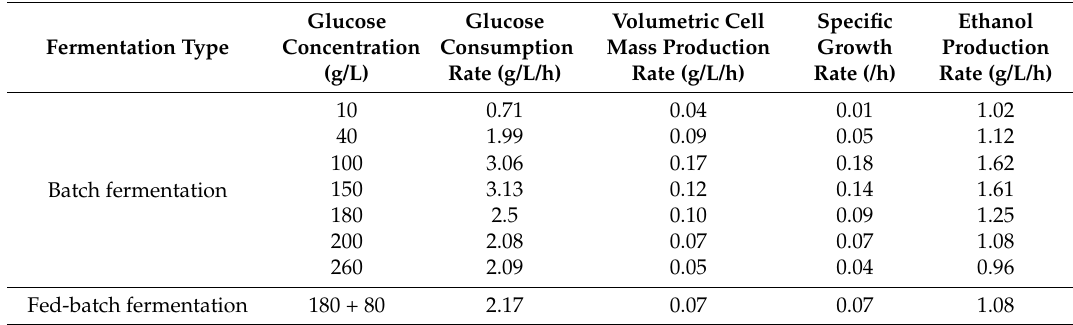
Table 1. Kinetic parameters for the batch and fed-batch ethanol